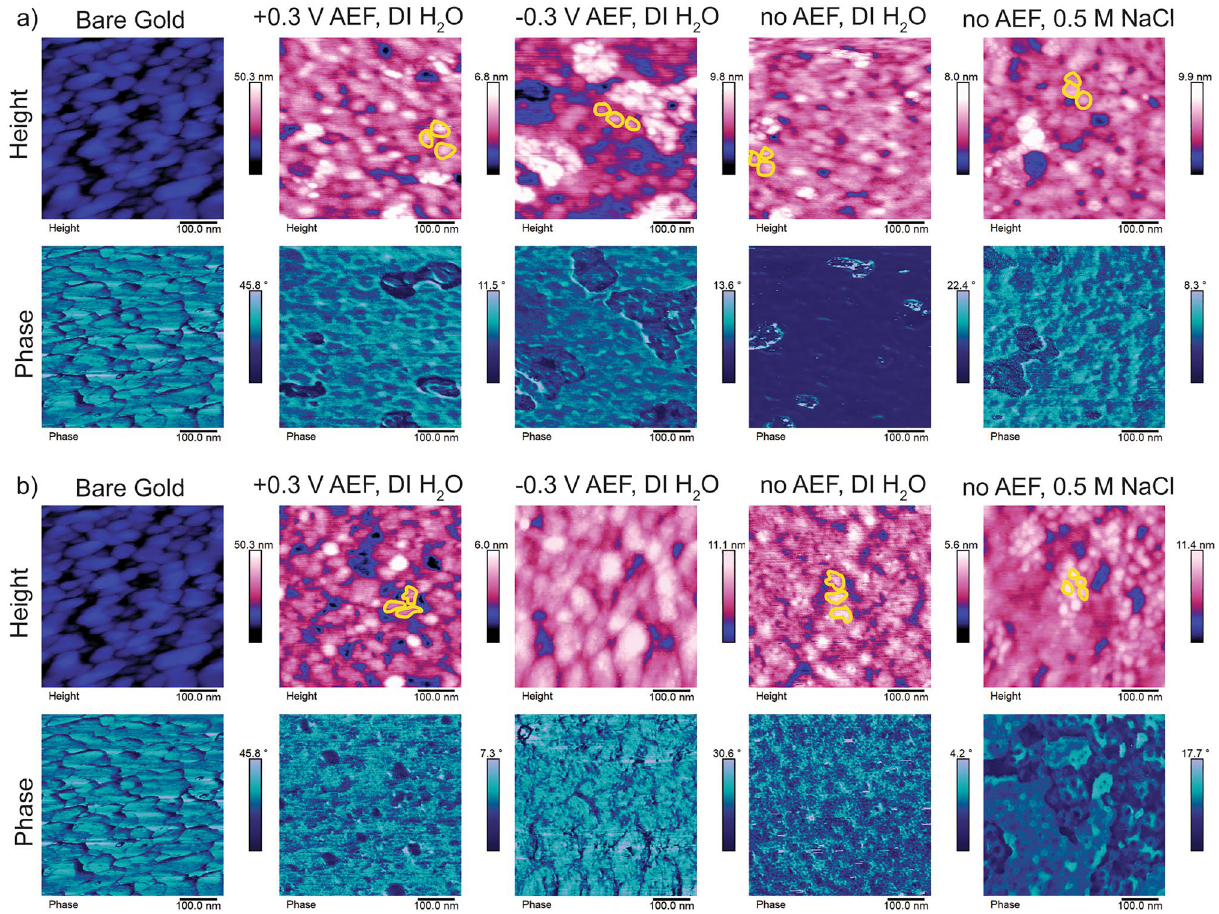
Figure 5. AFM images of grafted ELP show that charge/hydrophobicity and AEF impact morphology. Height and phase contrast images of ( a ) uncharged ELP and ( b ) (−)charged ELP grafted on gold QCM sensors at + 0.3 V AEF in DI water, − 0.3 V AEF, with no AEF in DI water, and with no AEF in 0.5 M NaCl. A bare gold QCM sensor is provided for reference. Example morphologies are outlined in yellow. All voltages are vs. a Ag/ AgCl